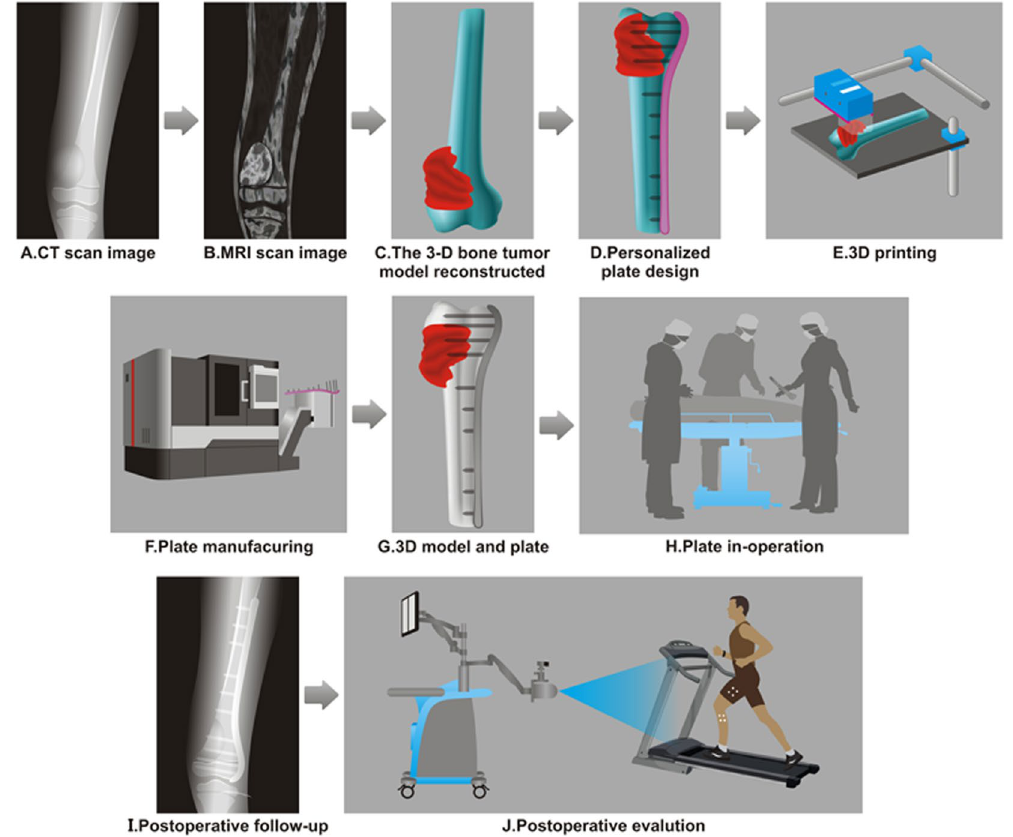
Figure 1. The current global procedure for the designed clinical study. ( A ) CT scan is first performed on the tumorous bone. ( B ) The MRI scan image is then performed on the tumorous bone. ( C ) In accordance with the merged CT-MR image, a 3D model of the tumorous bone is constructed using Mimics software, with tumor being highlighted in red. ( D ) The 3D model shown in C is then used to design a personalized titanium plate (pink) using UG software. ( E ) 3D printing is used to print the bone model shown in ( C ). ( F ) A numerical control machine is used to fabricate the personalized titanium plate shown in ( D ). ( G ) The fabricated titanium plate is combined with the 3D printed tumorous bone to match the model shown in ( D ) in order to test if the plate matches the tumorous bone as modeled. ( H ) The fabricated personalized plate is then used to fix the bone structure after the surgery removal of osteosarcoma and the bone repair using the mixture of allograft bone and cement. ( I ) The recovery of the patient is followed by X-ray examination and gait